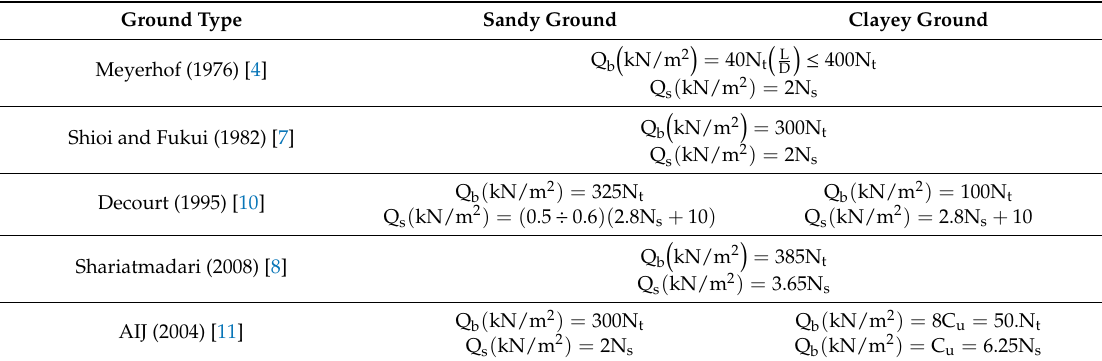
Table 7. Comparison of SPT methods for predicting the pile bearing capacity